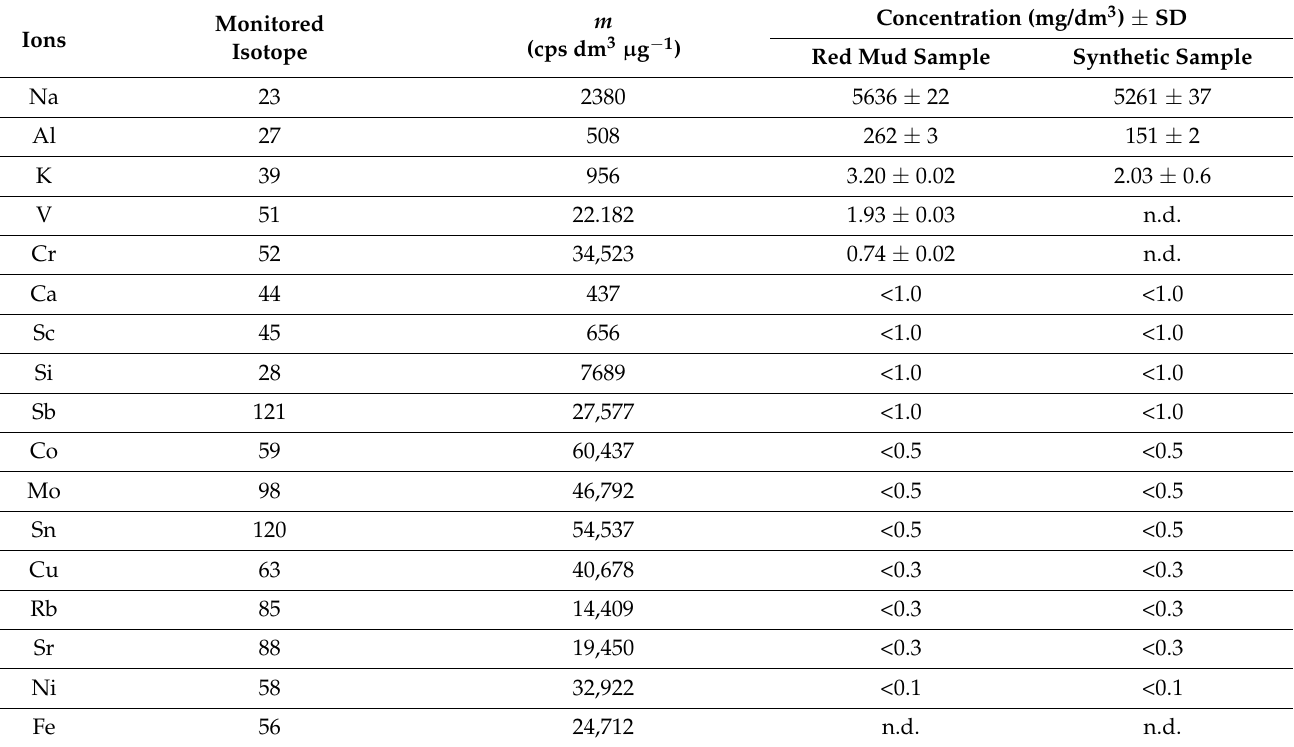
Table 2. The results of the ICP-MS investigation on the filtrates of water solubility